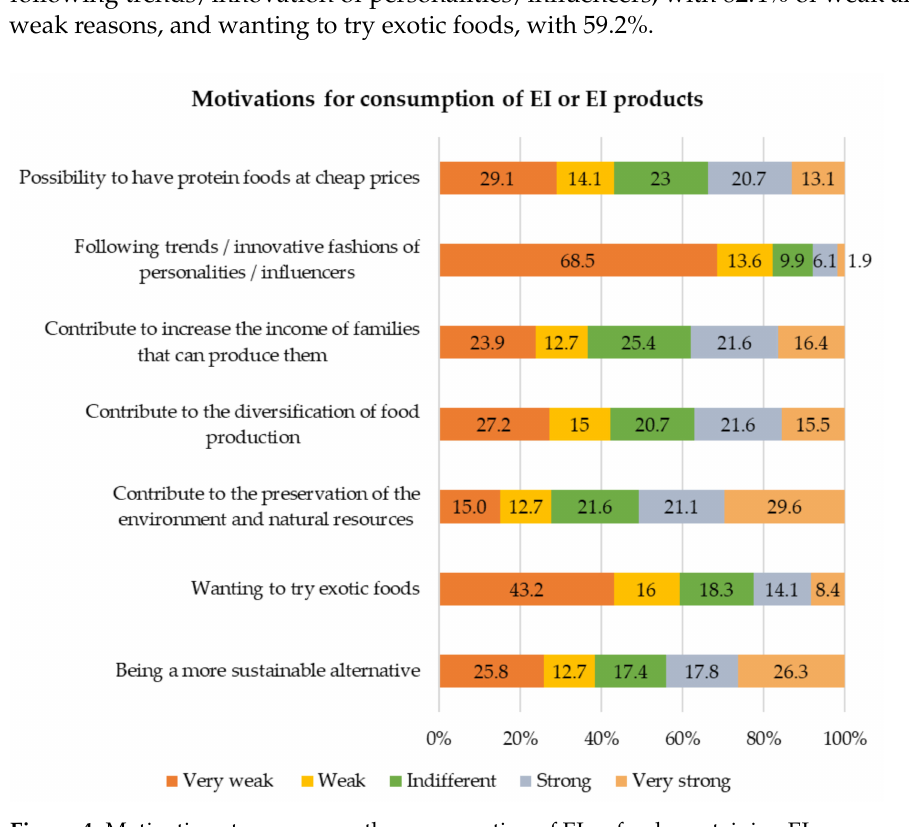
Figure 4. Motivations to encourage the consumption of EI or foods containing